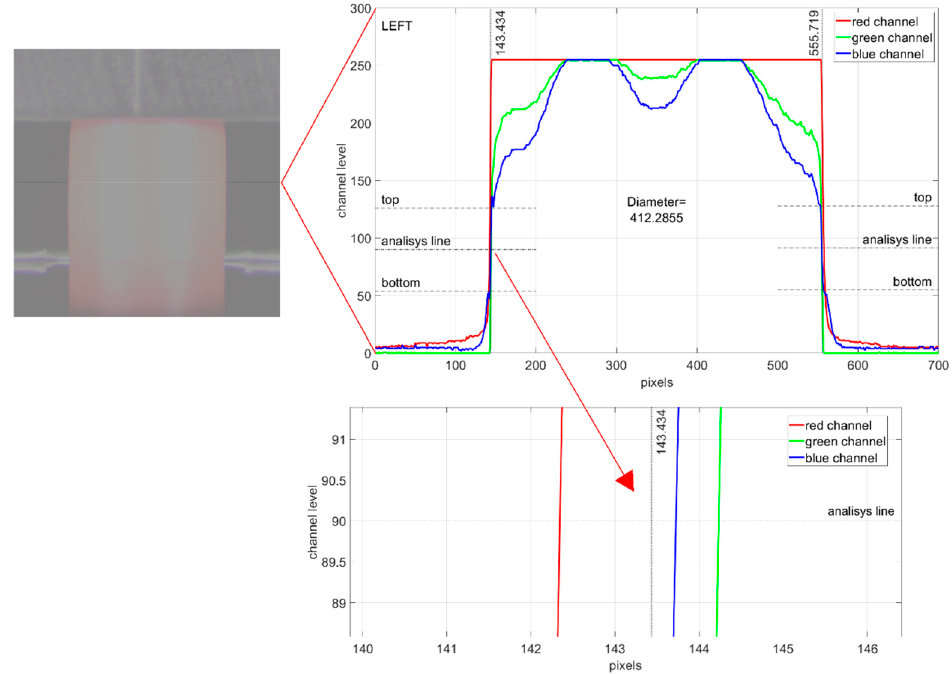
Figure 8. Boundary analysis of the specimen using RGB decomposition. Red arrow indicates analisys line region (zoomed).